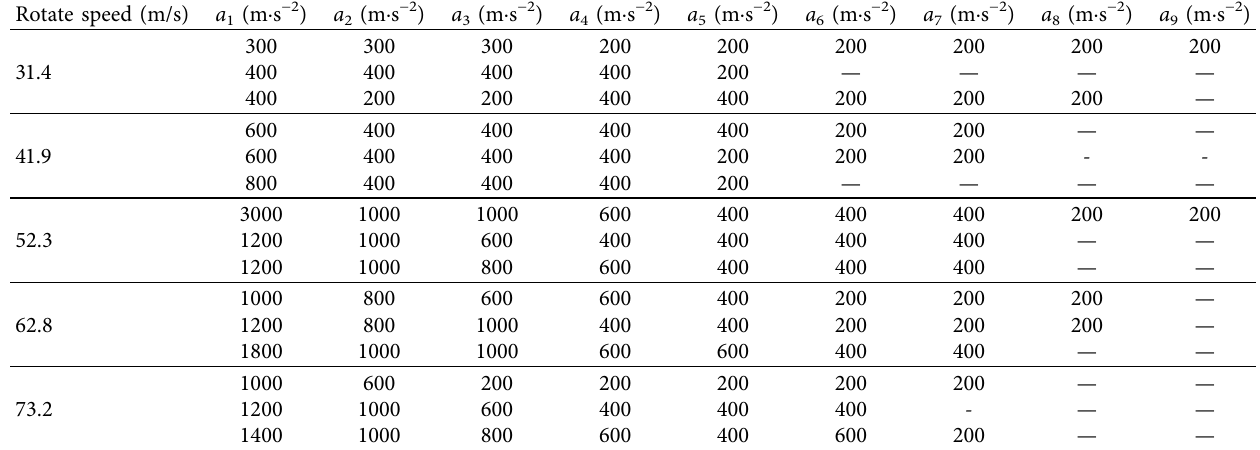
Table 2: Calculation of the flight trajectory TC4 sparks.